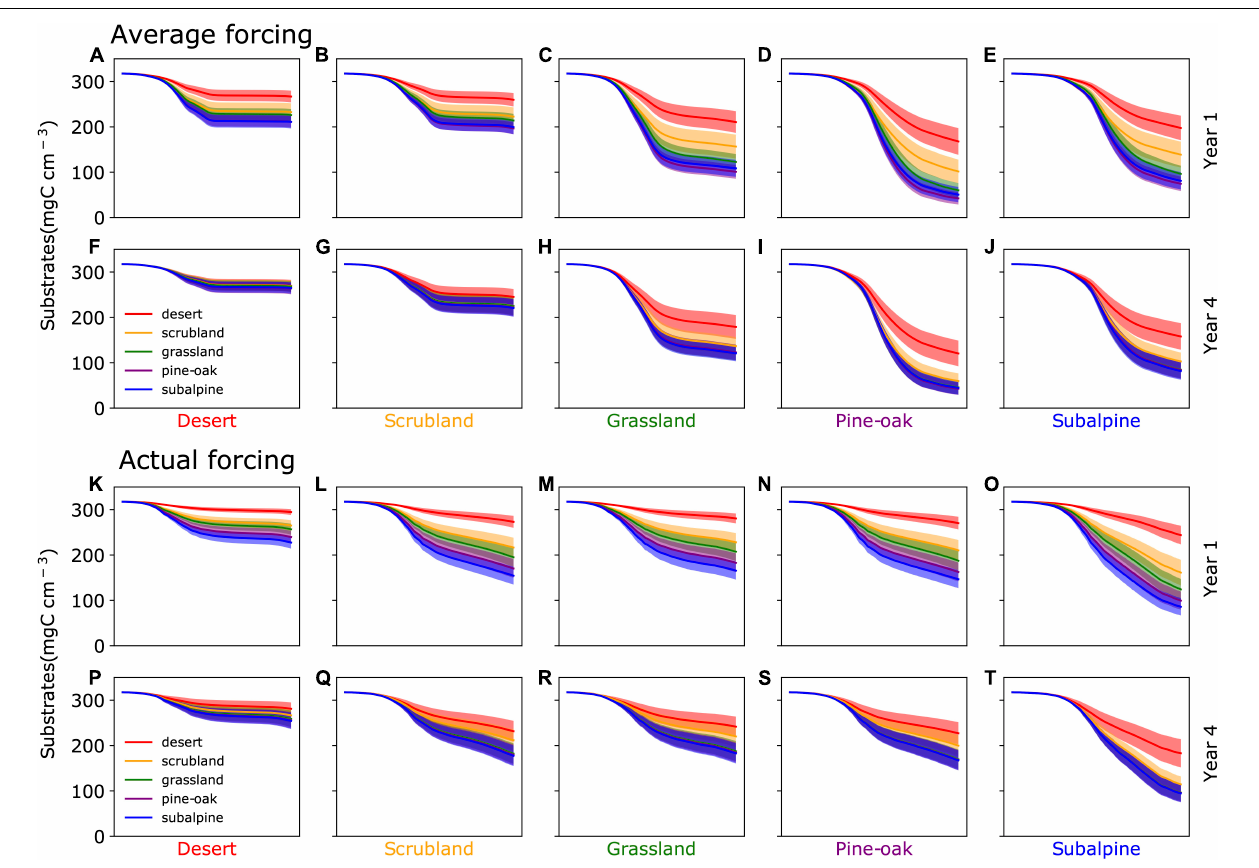
FIGURE 2 | Decomposition across the gradient during the 1st year and 4th year after transplant under both average forcing (A–J) and actual forcing (K–T) . The color band is 90% confidence interval ( n = 20).